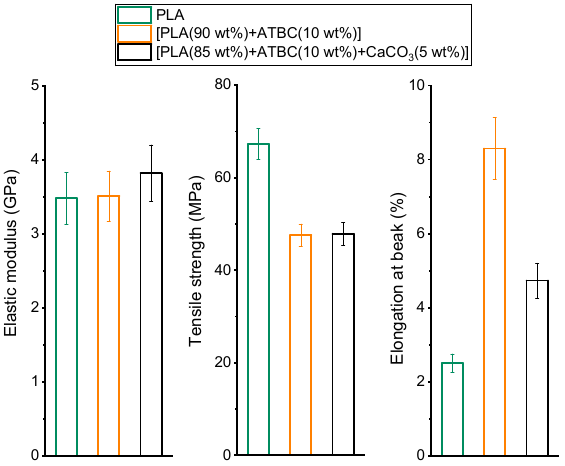
Figure 4. Elastic modulus, tensile strength and elongation at break of PLA and PLA mixed with (1) ATBC and (2) ATBC and the mineral filler CaCO 3 at the concentrations indicated.